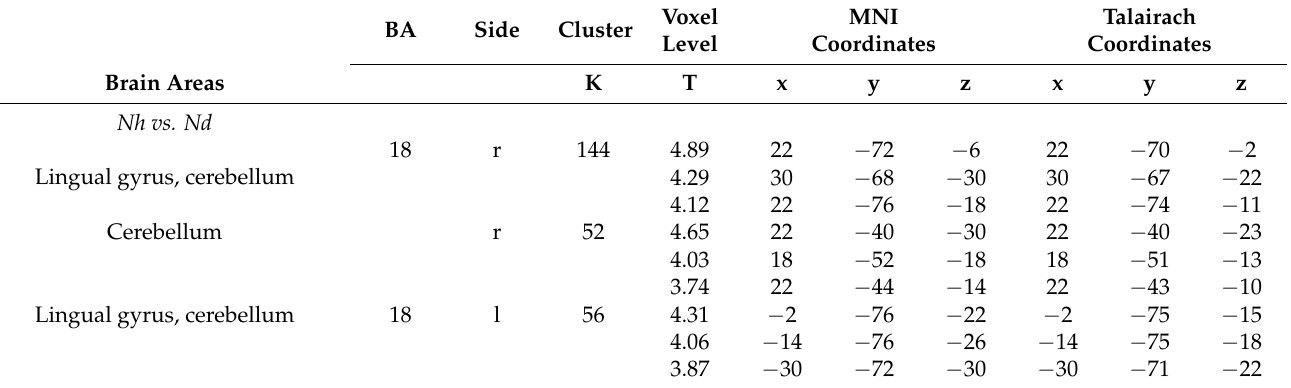
Areas of signi fi cant correlation with PD scores for the contrast “posing neutral and perceiving happiness” vs. “posing neutral and perceiving disgust”; BA = Brodmann area; l = left; r = right; cluster size threshold k > 27, corrected at α < 0.05.